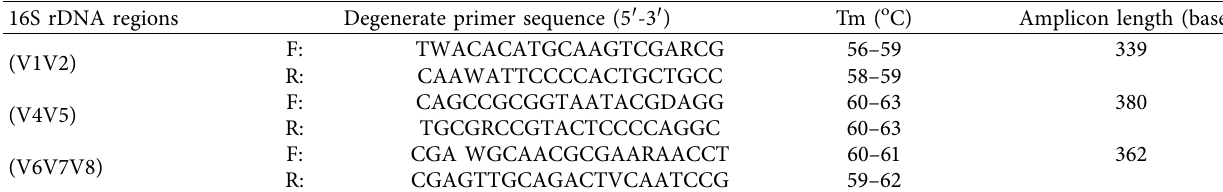
Table 2: Degenerate 16S rRNA primers for PCR